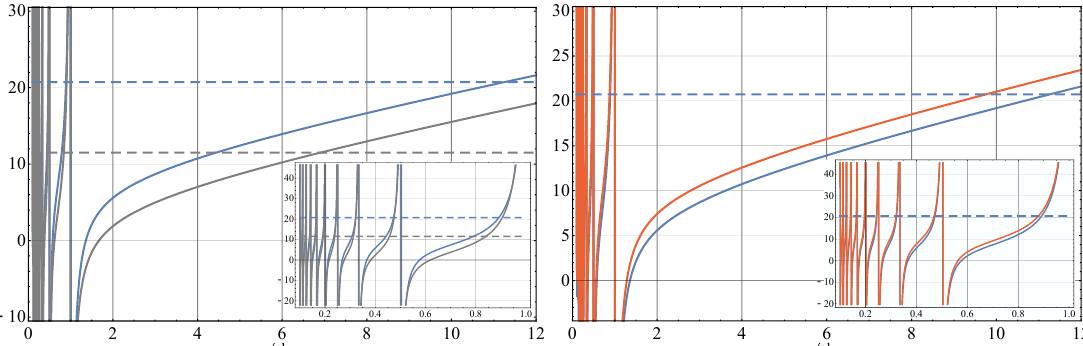
Figure 3. (color online) Energy levels of the Hydrogen atom in strong magnetic fields. The left panel illustrates only the lowest levels ( m = 0) for B = 10 5 ( b ≈ 5.3 ) (solid gray lines) and for B = 10 9 (cid:0) (cid:1) b ≈ 5.3 × 10 4 (solid blue lines). In the right panel, all lines were computed for B = 10 9 , where the blue ones correspond to m = 0 while the red ones to m = 3. In both panels, the horizontal dashed lines refer to ln10 5 ≈ 11.5 (in gray) and ln10 9 ≈ 20.7 (in blue).